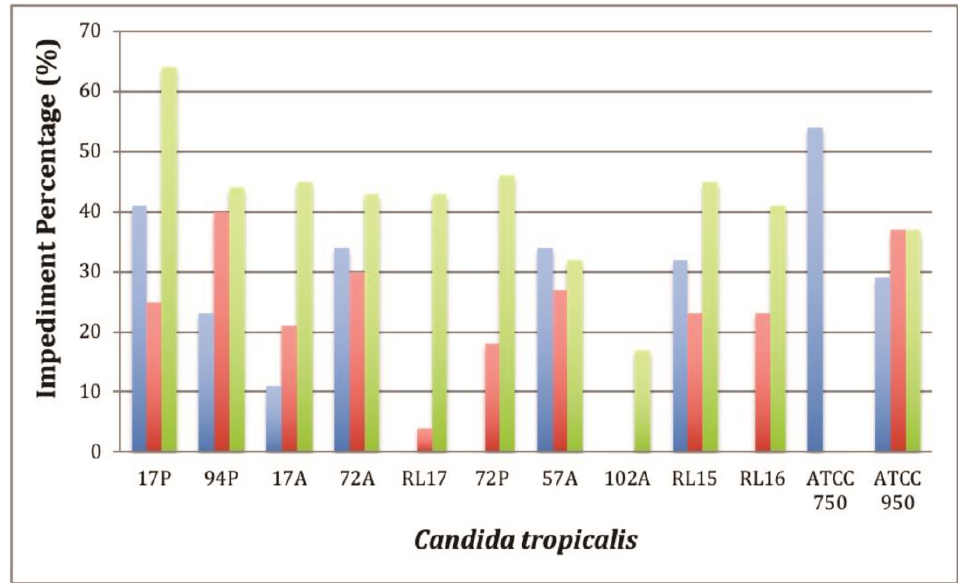
Figure 7. In vitro minor antibiofilm concentration assay: impediment percentage for HDPE.MeS.0125 (blue bars), HDPE.MeS.0250 (red bars), and HDPE.MeS.0500 (green bars).